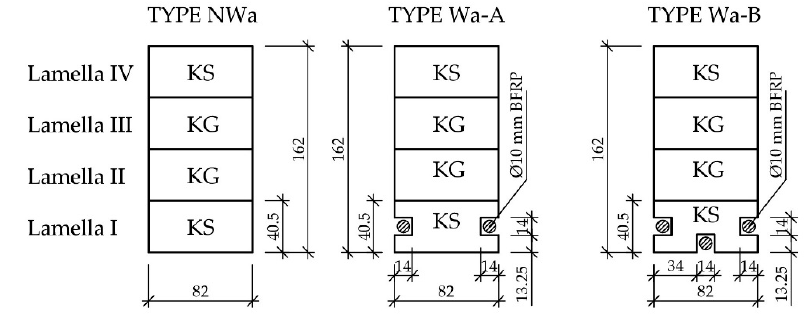
Figure 2. Transverse cross-sections of “Wa” type beams [dimensions in mm, KS - medium quality class, KG - lower quality class].